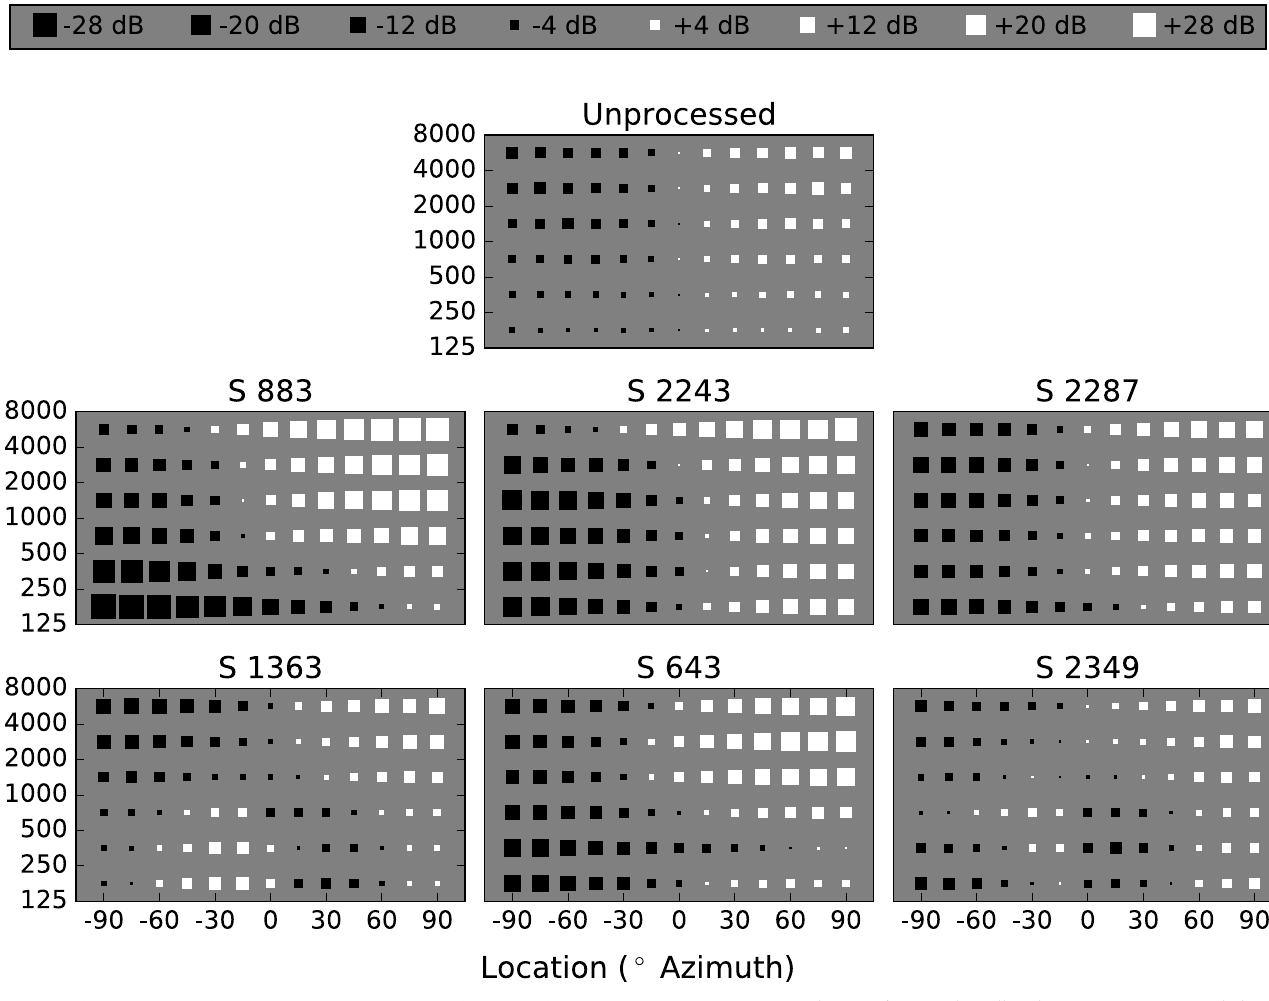
Fig 9. Pre- and post-processed ILD estimates as a function of azimuth for each participant. Acoustic analysis is of 500-ms broadband Gaussian noise, recorded from source locations at +/-90 degrees in 15-degree steps, using omnidirectional 1/4” microphones mounted on an acoustic manikin facing forward just above the auricles, as was done during testing. The top panel depicts ILDs in the unprocessed condition, and the the lower six panels each represent ILDs after processing using the six listeners corrective ILD functions, one panel per listener. In each panel, maker size represents ILD magnitude in each of the six frequency bands used in the study as a function of source location. Black markers represent apparent source locations to the left, and white markers to the right.